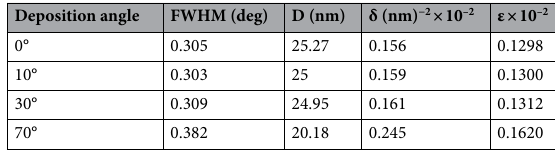
Table 2. Average grain size along (012) plane strain (ε), and dislocation density (δ).